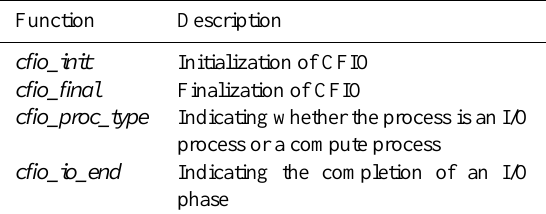
Table 1. Additional Functions of